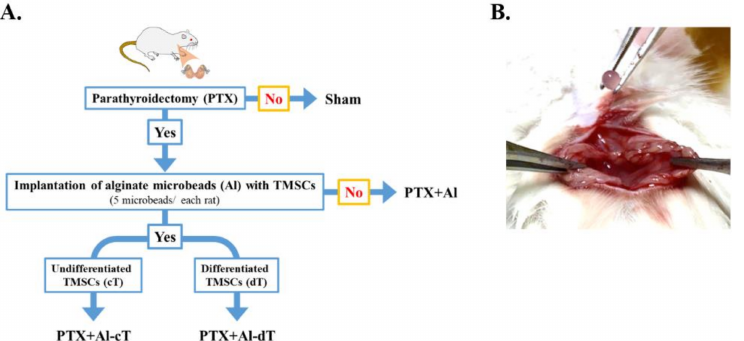
Figure 4. Schematic diagram of in vivo experimental groups ( A ) and image of the implantation procedure ( B ).